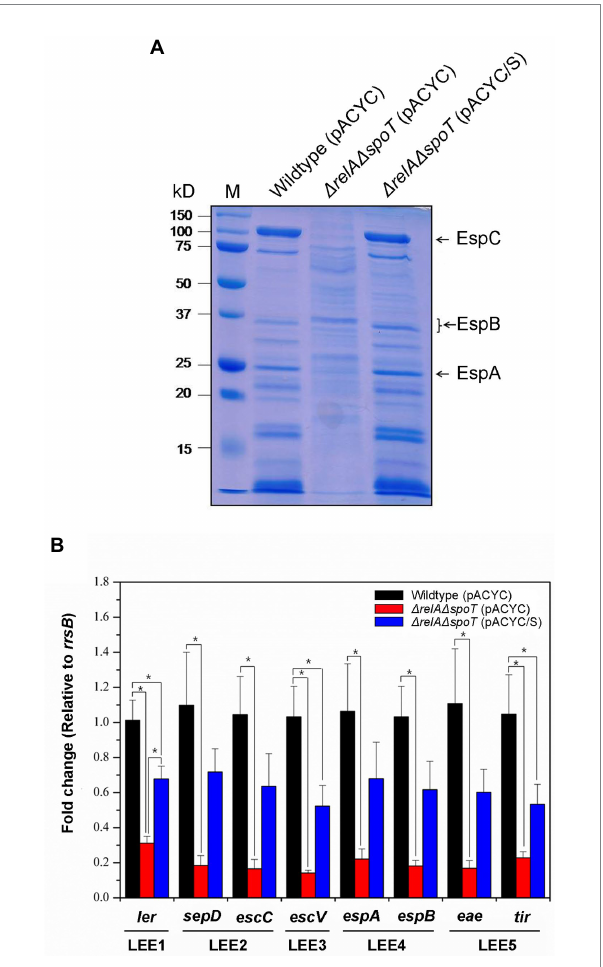
FIGURE 5 The relA and spoT dependent expression of LEE pathogenicity island (LPI) genes of EPEC proteins. Wildtype, Δ relA Δ spoT mutant, and spoT - complemented mutant strains grown in Luria-Bertani (LB) at 37 ° C for 18 h were diluted with pre-warmed LB and further incubated at 37 ° C. (A) Secreted protein profiles of the wild type and its Δ relA Δ spoT mutant strain. Secreted proteins were harvested, concentrated, and analyzed using 10% sodium dodecyl sulfate–polyacrylamide gel electrophoresis. Lane M, Protein ladder. Wildtype (pACYC), E2348/69 strain carrying pACYC184; Δ relA Δ spoT (pACYC), E2348/69 Δ relA Δ spoT mutant carrying pACYC184; Δ relA Δ spoT (pACYC/S), E2348/69 Δ relA Δ spoT mutant carrying pACYC/S. (B) Transcriptional repression of LPI genes by ppGpp. Expression patterns of major virulence associated genes including ler , sepD , escC , escV , espA , espB , eae , and tir were analyzed using quantitative real-time PCR. Values are presented as mean ± standard error of the mean ( n = 3). Statistical significance was obtained by Student’s t -test (* p <